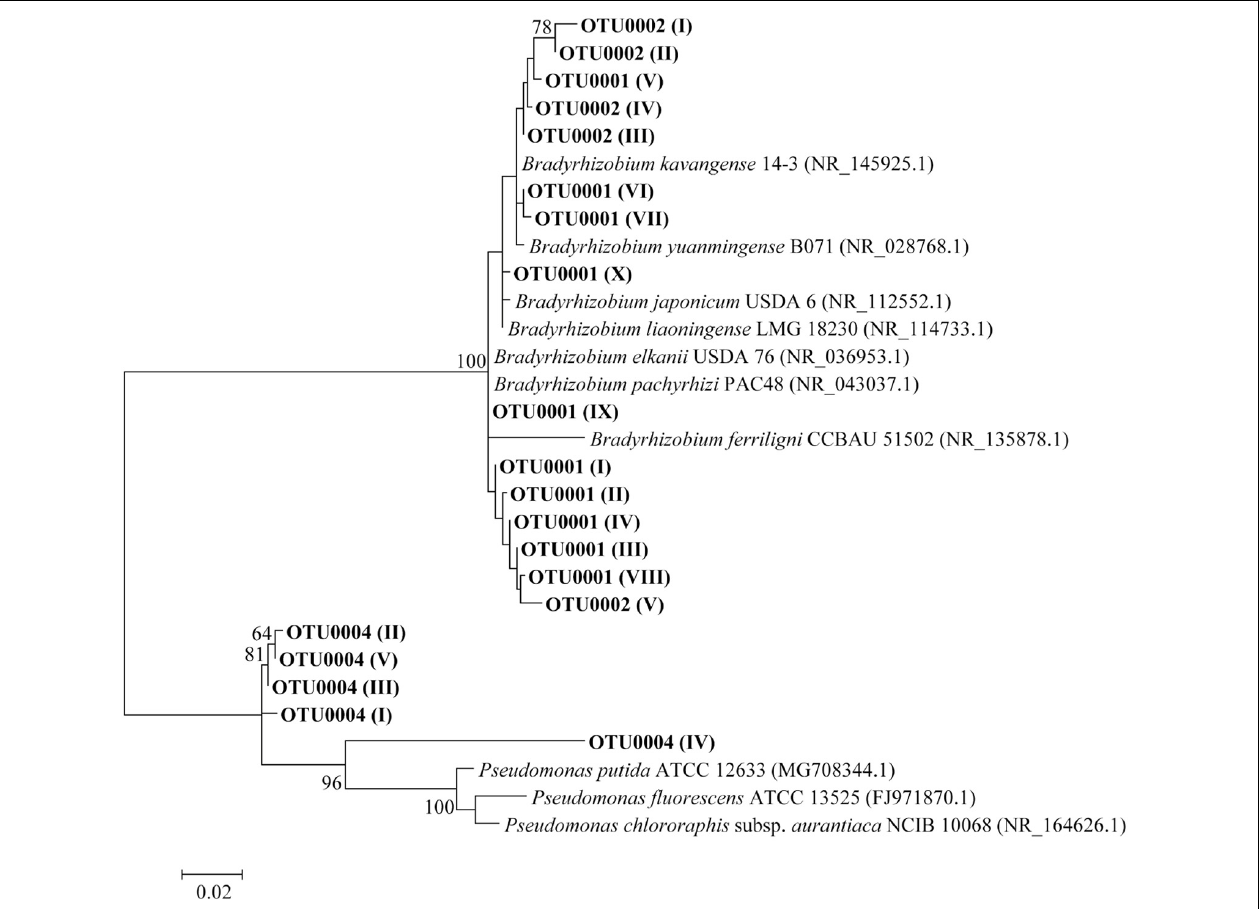
FIGURE 8 | Maximum likelihood phylogenetic tree for OTUs classified, based on 16S rRNA gene sequences. Tree estimated through 441 base pair positions. The 10 most abundant sequences from OTU0001 and five from OTU0002 and OTU0004 were used. Letters in Roman numerals indicate order of abundance of the strings within their respective OTUs. Bootstrap values are shown when the relationships represented have been observed in at least 50% of 1,000 replicates. The tree was obtained using the Kimura 2-parameter + G